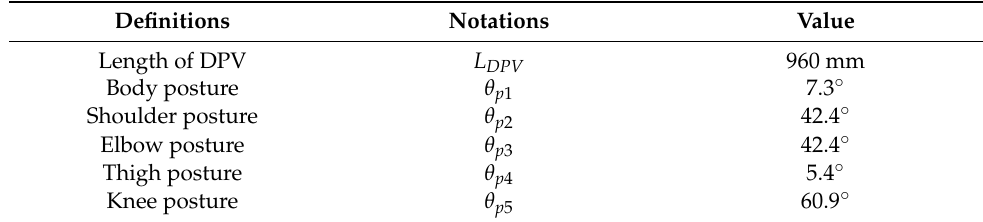
Table 3. Posture angle at T 0